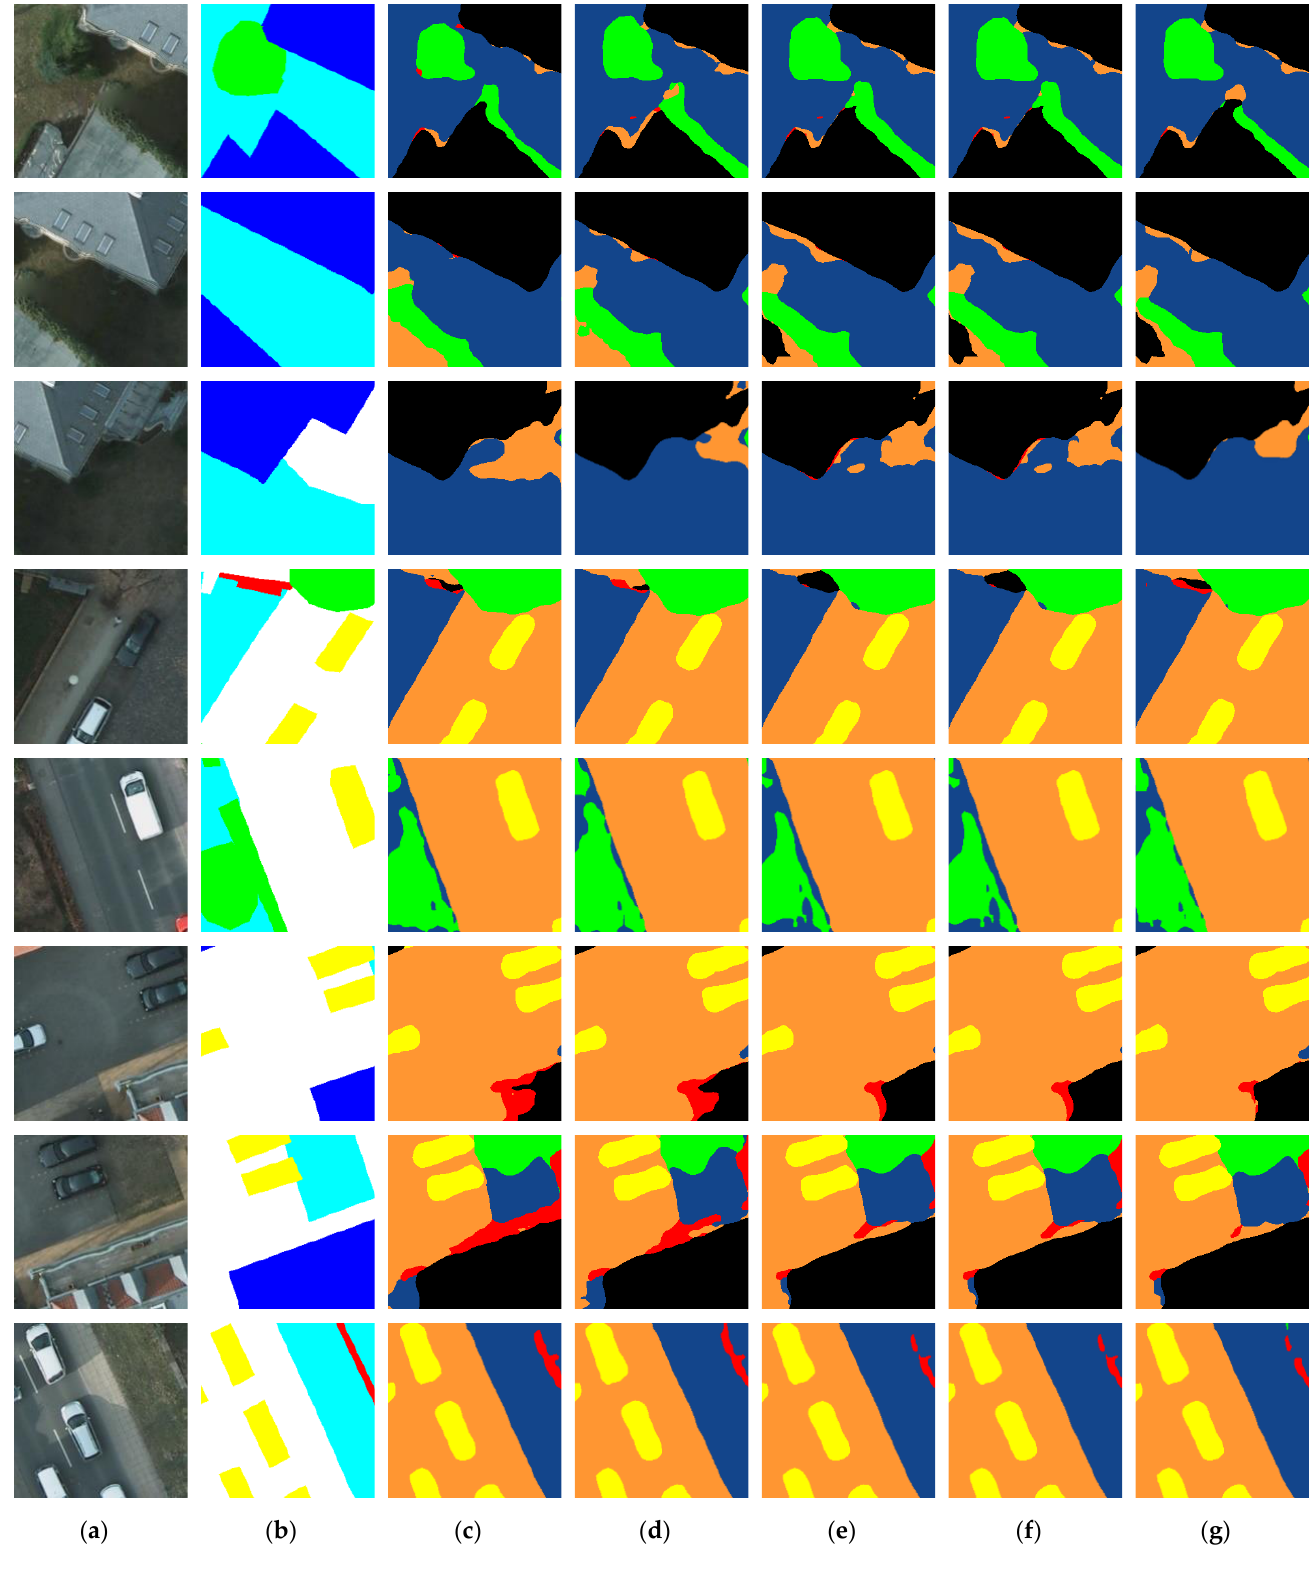
Figure 15. Examples of segmentation details of different models on the ISPRS Potsdam dataset: ( a ) original image, ( b ) ground truth, ( c ) SegNet, ( d ) U-Net, ( e ) PSPNet, ( f ) Deeplabv3+, ( g ) LPASS-Net, where the category details are shown in Table 8.